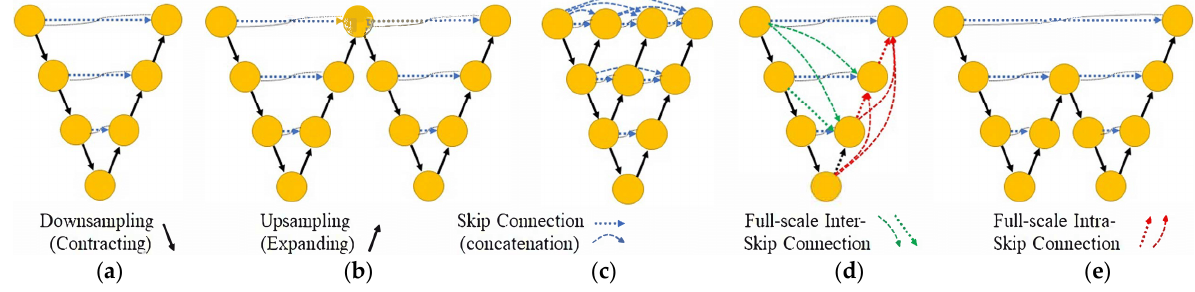
Figure 2. Graphical visualization of different architectures for both the existing state ‐ of ‐ the ‐ art U ‐ Net models and the proposed AID ‐ U ‐ Net with a direct path of length 4: ( a ) Wide or Vanilla U ‐ Net, ( b ) W ‐ Net (Series or Cascaded U ‐ Net), ( c ) U ‐ Net++ (Nested U ‐ Net), ( d ) U ‐ Net3+ (Full ‐ scale skip), and ( e ) AID ‐ U ‐ Net.